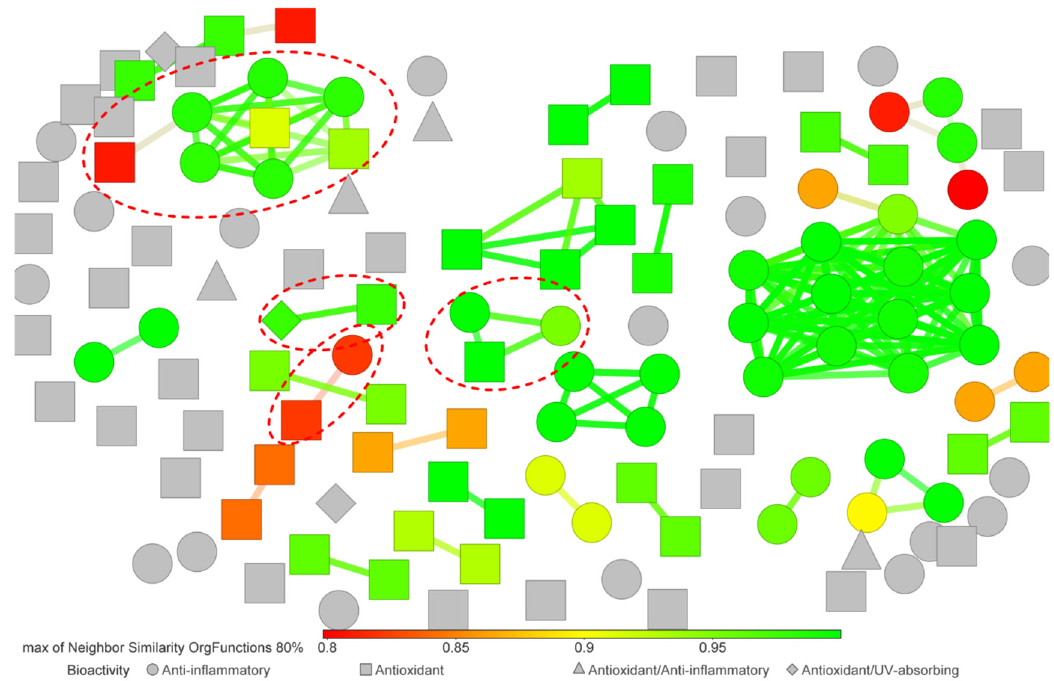
Figure 6. Similarity analysis of Streptomyces -derived photoprotective compound library. The similarity analysis was carried out using the OrgFunctions descriptor. The color scale bar indicates the level of similarity from red (0.8) to green (1.0). Each marker shape indicates the bioactivity reported for a given compound. The red dotted circles highlight compound clusters where metabolites with different bioactivity were grouped together.